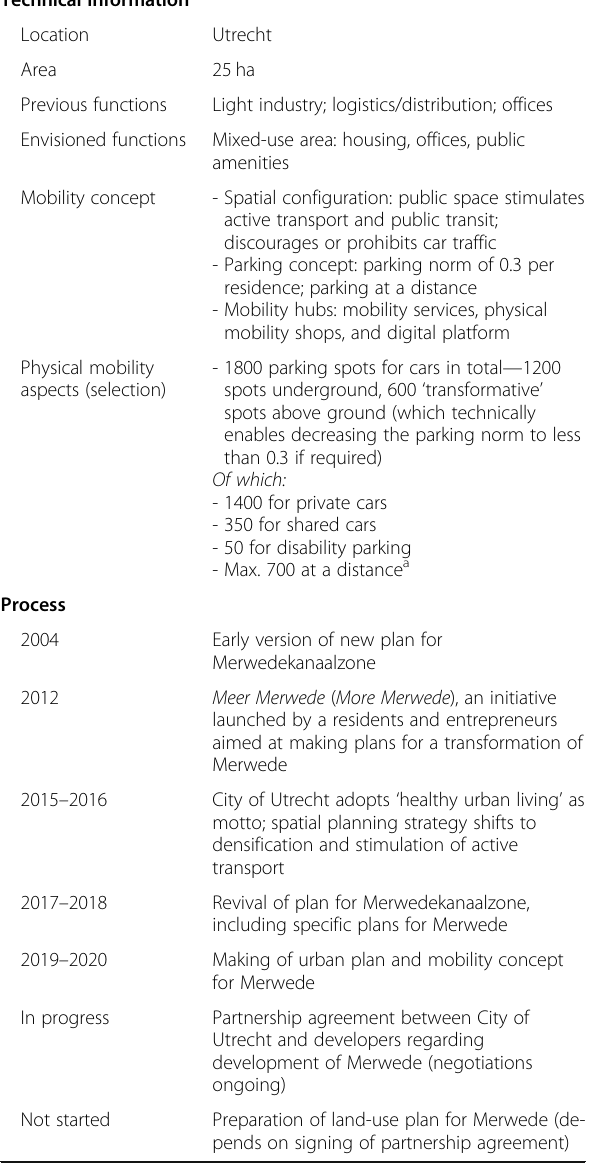
Table 1 Provisional overview of Merwede — technical specifications and chronology of planning process (adapted from workshop P1; see Section 5 on